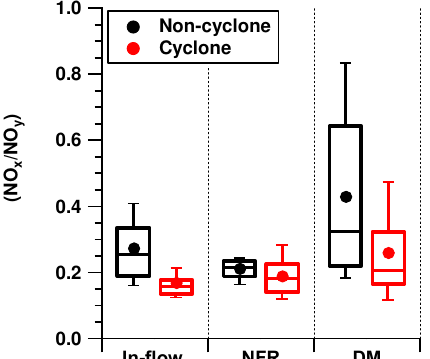
Figure 10. Statistical representation of the distribution of the mix- ing ratios of NO x /NO y within the three study regions. The box and whiskers indicate 10th, 25th, 75th, and 90th percentiles, while the solid lines and circles mark the median and mean values, respec- tively.